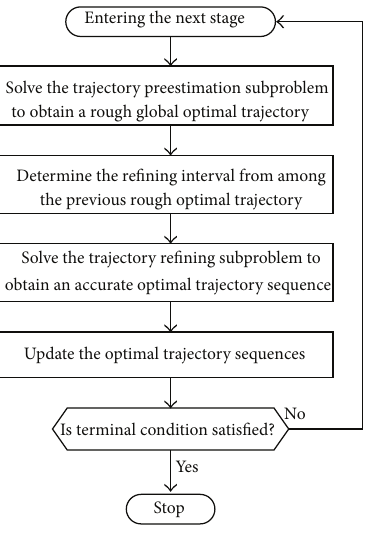
Figure 3: Flowchart of the multistage trajectory control strategy.